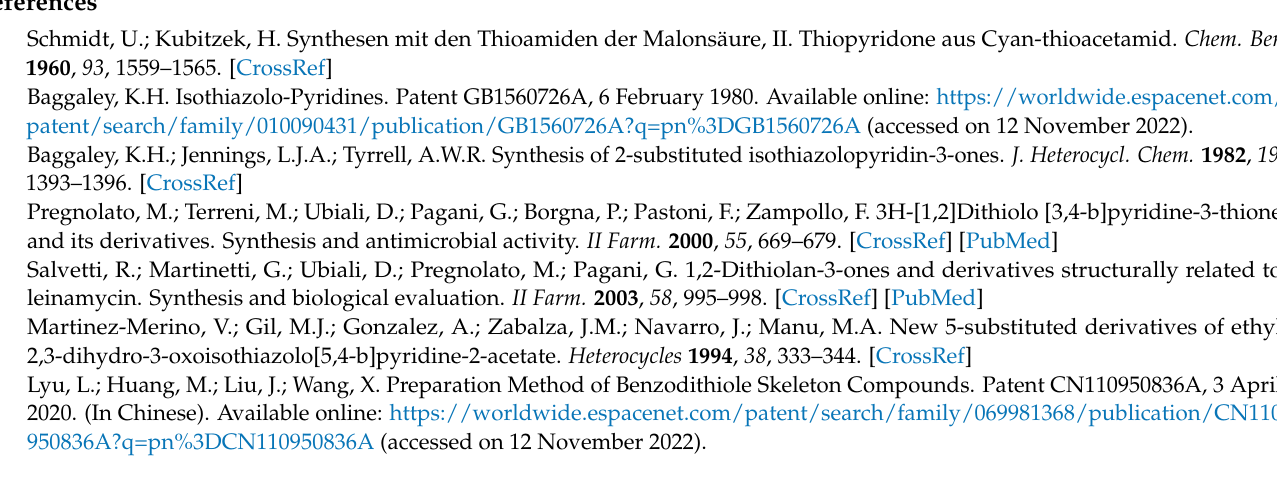
Table S9. The observed correlations in the 1 H– 13 C HSQC and 1 H– 13 C HMBC 2D NMR spectra of dithiolopyridine 15f ; Figure S26. HRMS spectrum of dithiolopyridine 15a ; Figure S27. HRMS spec- trum of dithiolopyridine 15b ; Figure S28. HRMS spectrum of dithiolopyridine 15c ; Figure S29. HRMS spectrum of dithiolopyridine 15d ; Figure S30. HRMS spectrum of dithiolopyridine 15e ; Figure S31. HRMS spectrum of dithiolopyridine 15f